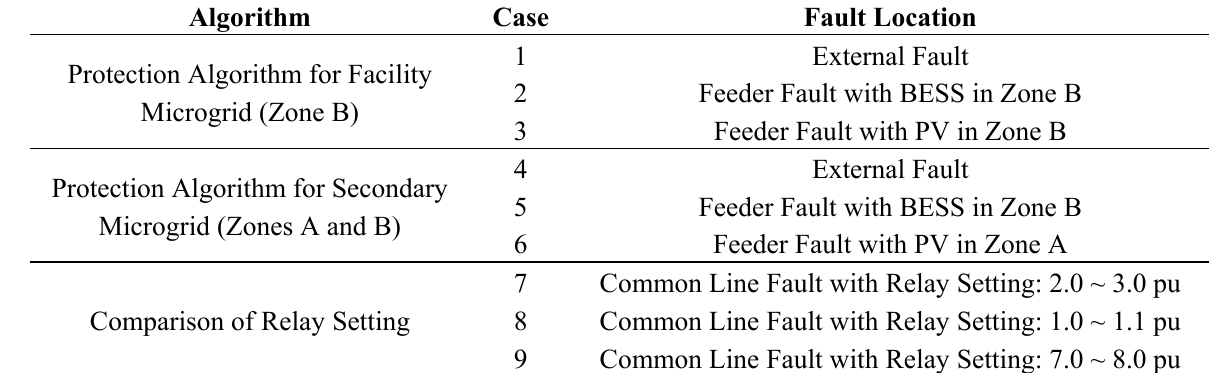
Table 2. Simulation